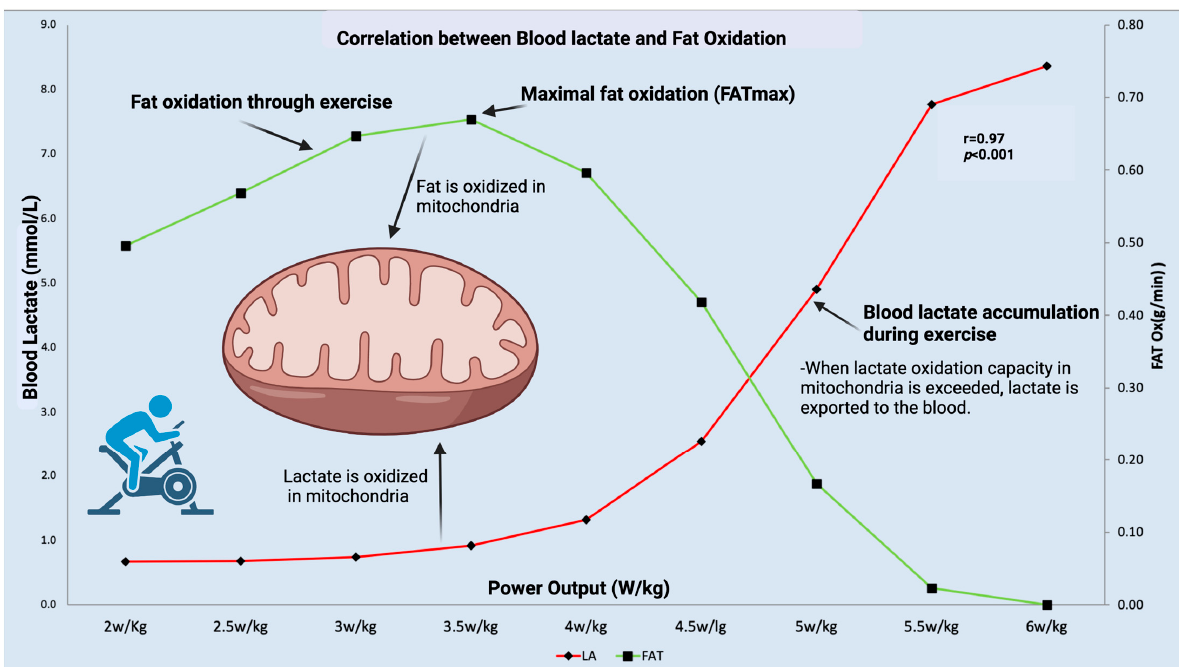
Figure 3. Example of a metabolic test used to indirectly measure mitochondrial capacity during exercise through measuring FATox and blood lactate levels (modified from San–Millán and Brooks, 2018) [24].